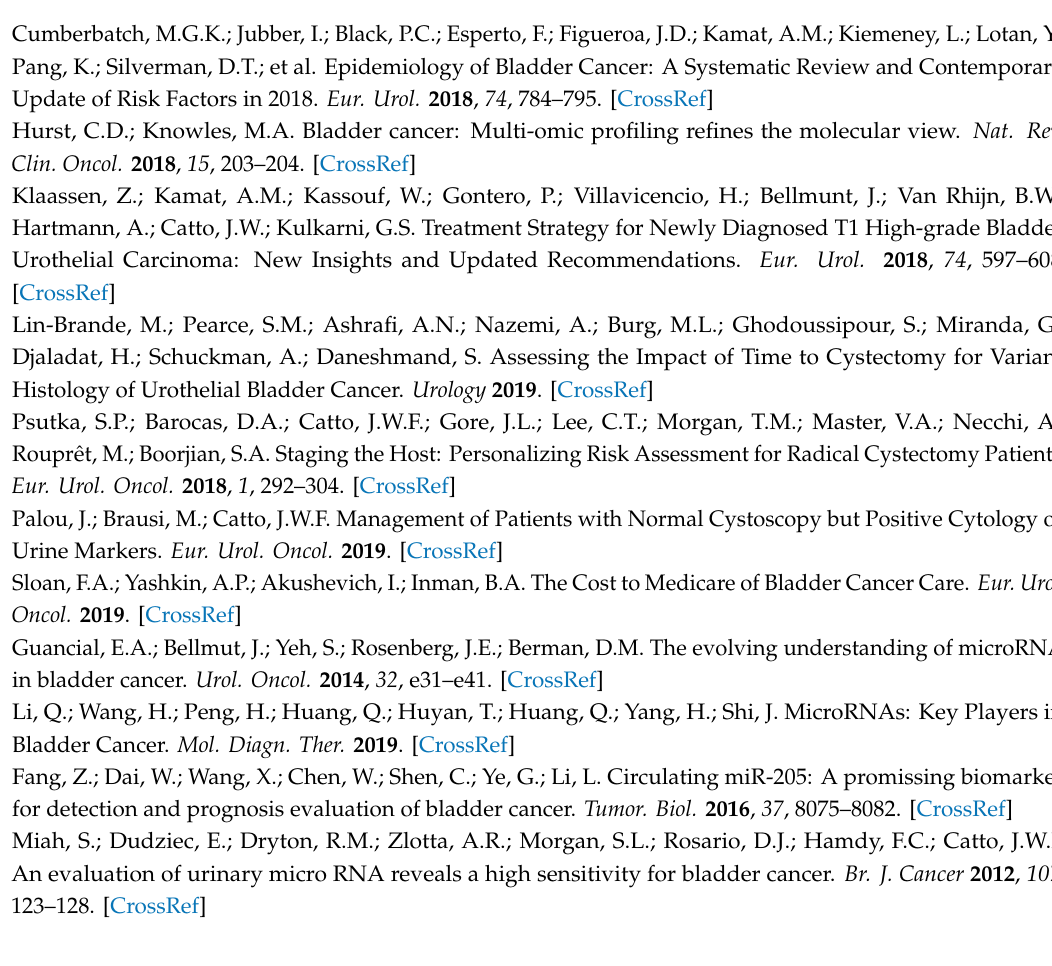
Table S1: Characteristics of the patients group. Table S2: Details of TaqMan MicroRNA assays. Table S3: Experimental details of the rt-PCR analyses according to the checklist of the MIQE Giudelines (minimum information for the publication of real-time quantitative PCR experiments) Table S4: Summary statistics of the normalized expression data of miRNAs in the three clinical sample groups (BC, NMIBC, MIBC) Table S5: ROC characteristics for A) selected miRNAs B) between AUC of di ff erent miRNAs Data File SF1: Raw data- expression